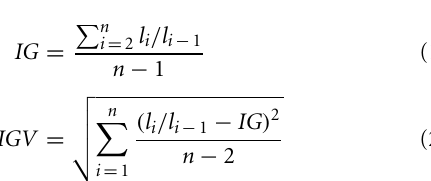
(C) and scanning electron microscopic (D) view. The protruding juvenile spiral has been marked by arrows in the light microscopy image. (E,F) Light microscopy images of Kummerforms of Globorotalia scitula , where the last chamber is smaller than the penultimate chamber. While the specimen in (F) shows a regular growth pattern (low IGV ) the specimen in (E) shows an increased IGV visible by the large variation in the size of individual chambers. Scale bars are 200 µ m in